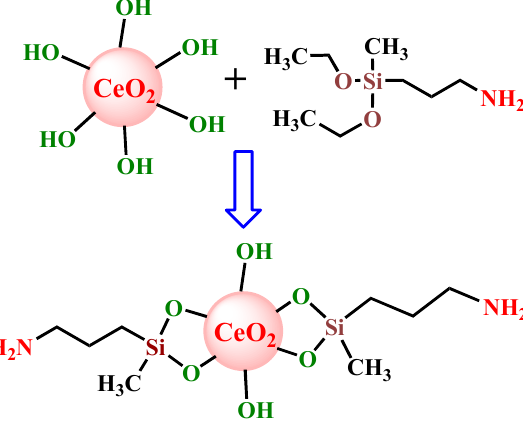
Figure 1. Schematic synthetic route for the functionalization of CeO 2 nanoparticles (NPs) with amino units.